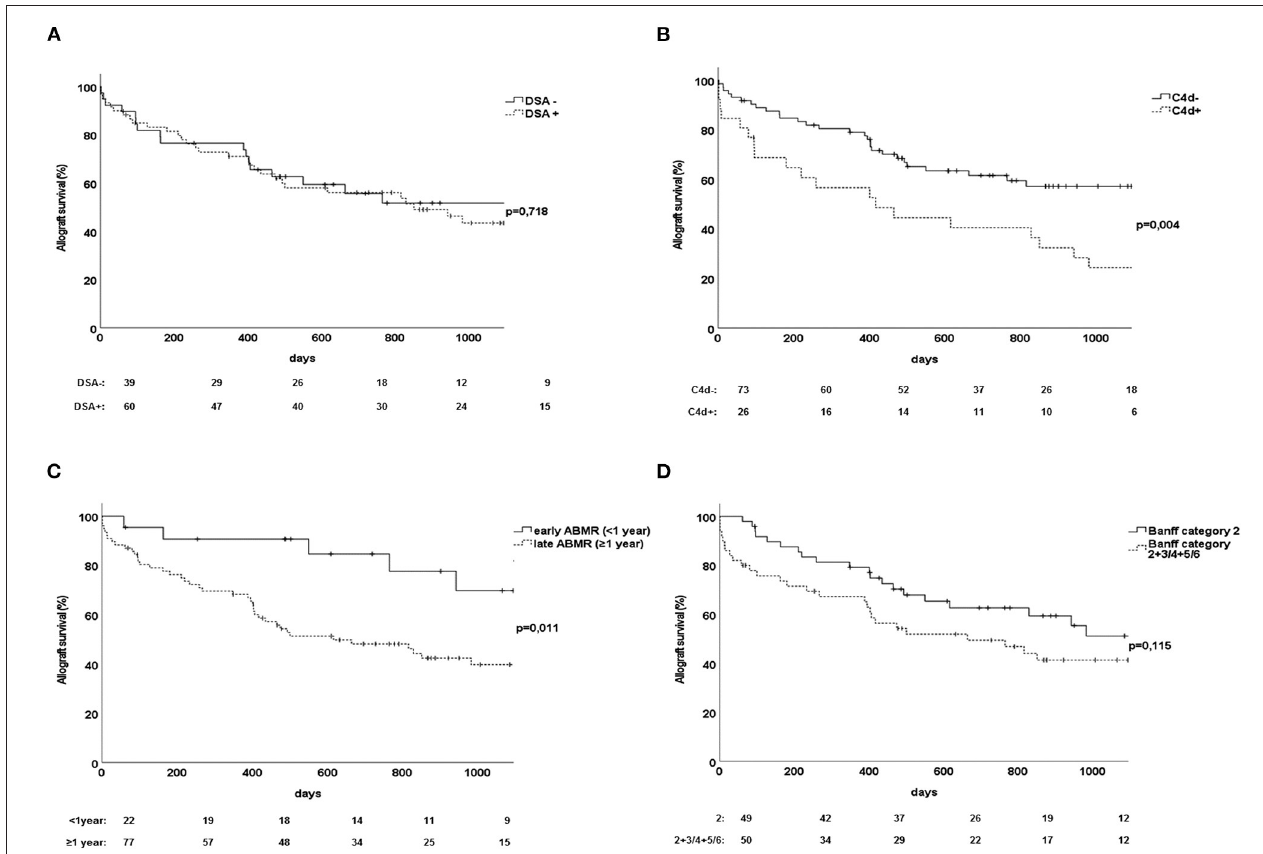
FIGURE 2 | Association of various factors related to accelerated allograft loss due to ABMR among 102 transplant recipients. (A) Influence of DSA status of ABMR on renal allograft survival. (B) Influence on renal allograft survival of C4d deposits among patients with biopsy-proven ABMR. (C) Allograft survival in relation to ABMR detected within the first year after transplant. (D) Allograft survival among patients with ABMR and Banff category 2 only compared to Banff category 2 in combination with other pathologic lesions (Banff category 3 or 4 and/or 5 or 6). ABMR, antibody-mediated rejection; DSA, donor-specific